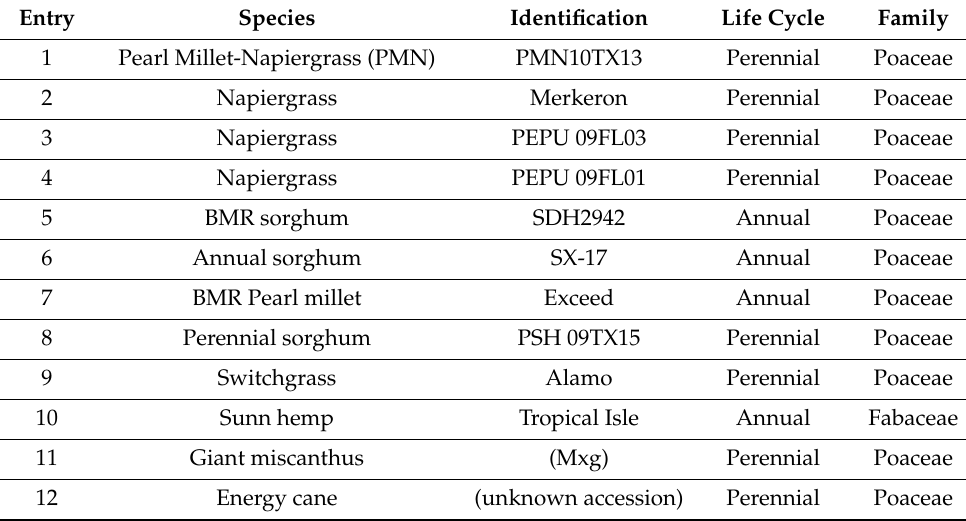
Table 1. Feedstocks utilized for field